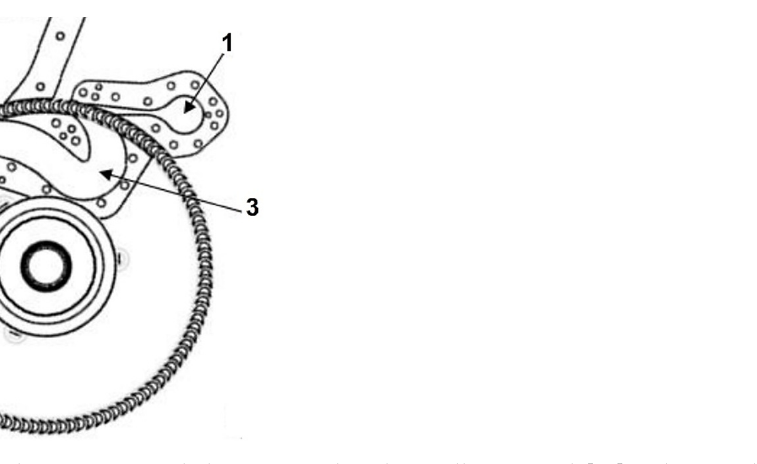
Figure 3. Radial velocity compounded re-entry turbine by Kryllowicz et al. [11] with two velocity stages (1 nozzle inlet, 2 blade wheel, 3 deflection channel).